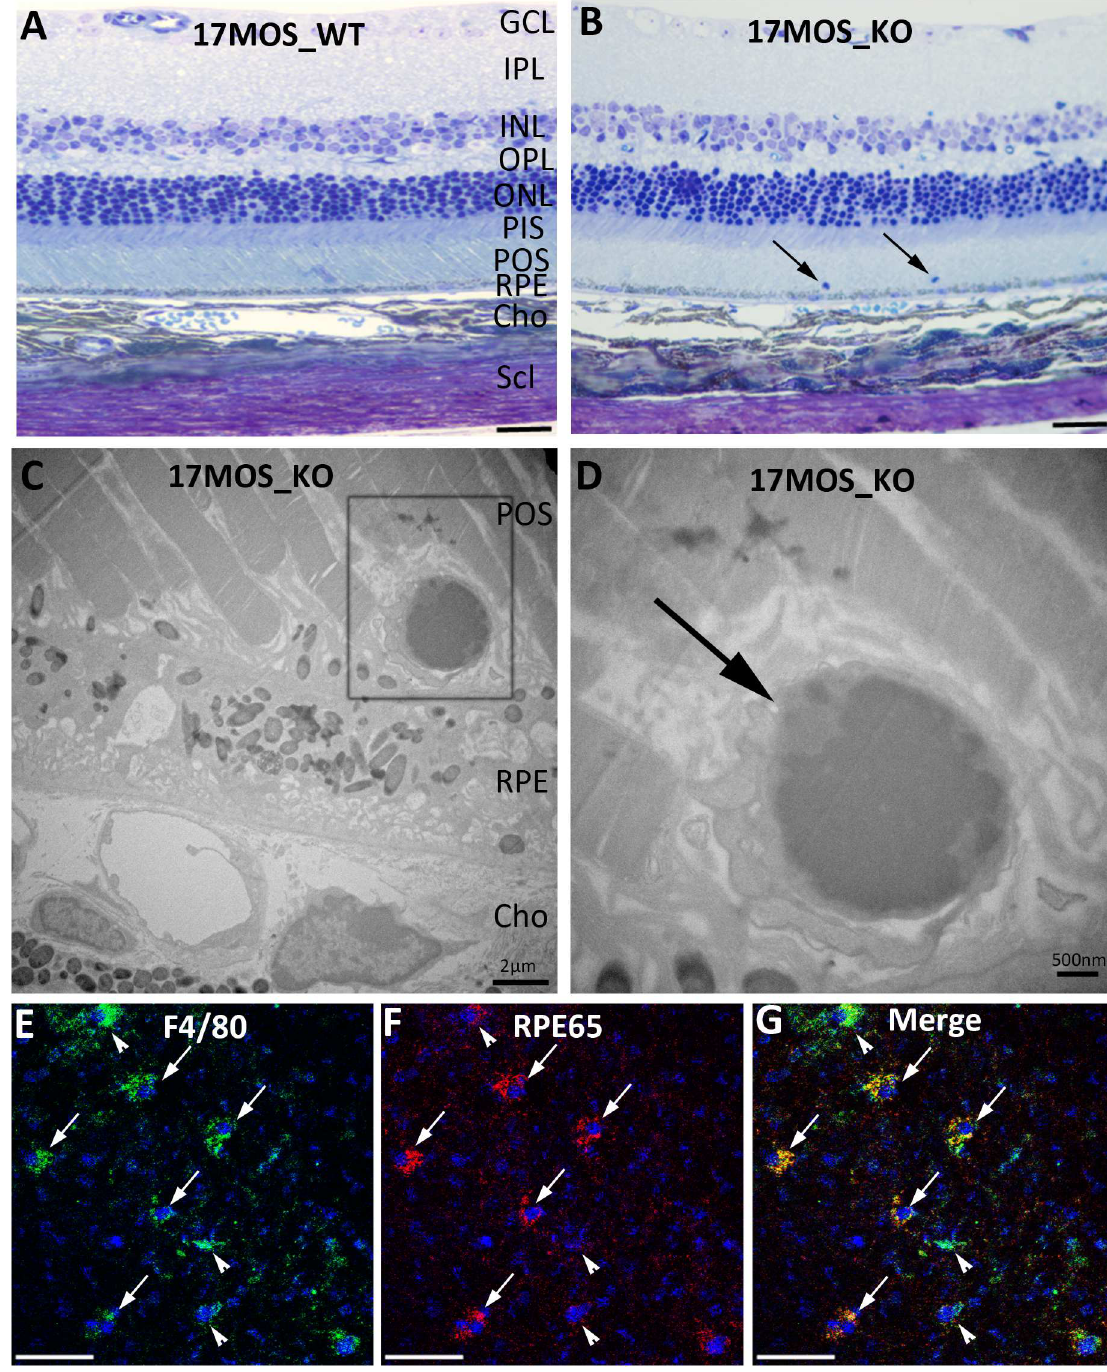
Fig 8. Increased subretinal immune cells in aged Cxcr5 -/- mice. ( A & B ) Representative toluidineblue-stained sections of 17-month-old C57BL/6WT mice ( A ) and Cxcr5 KO mice ( B ). Arrows indicatedthe subretinalimmune cells in the KO mice. ( C & D ) Transmission electron microscope(TEM) image of the photoreceptorouter segment/RPE/choroidinterface ( C ) and higher- resolution TEM image of the subretinal immune cells in the box ( C ). Arrow ( D ) indicatedthe subretinal immune cells. ( E-G ) Dual labelingof macrophage/microgliamarker F4/80 and RPE marker RPE65 with the RPE/choroid whole-mounts from the KO mice: F4/80 ( E ), RPE65 ( F ), and the merged( G ). Arrows indicatedthe cells that were immune positive for both markers. Arrowheads indicatedthe cells that were immune positive for F4/80, but negativeor had less staining intensity for RPE65. Scale bar: 50 μ m. GCL: ganglioncell layer; IPL: Inner plexiformlayer; INL: inner nuclear layer; OPL: outer plexiform layer; ONL: outer nuclear layer;